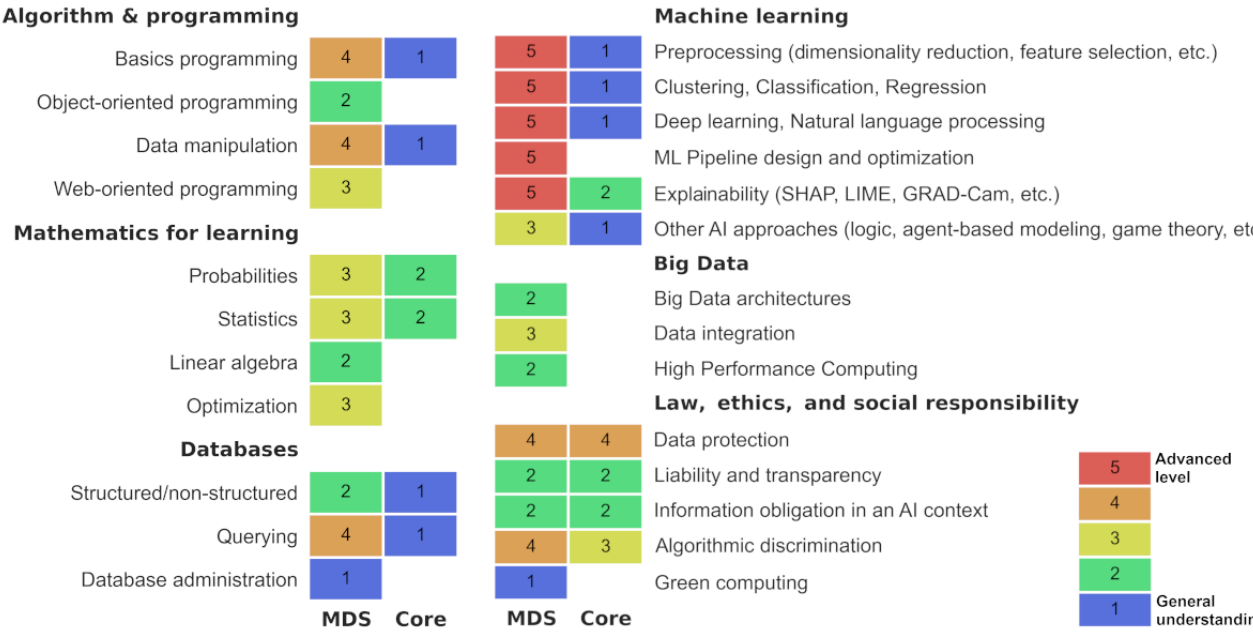
Figure 1. The proposition of a syllabus for Medical Data Scientists (MDS) and common core AI/ML in medical education (Core). While the Core program would concern all MD trainees and continuous education, the MDS specialty must go beyond this, and be built as an applied research program. The syllabus was divided into six categories, with details for each and expected levels. A specific level implies all levels below